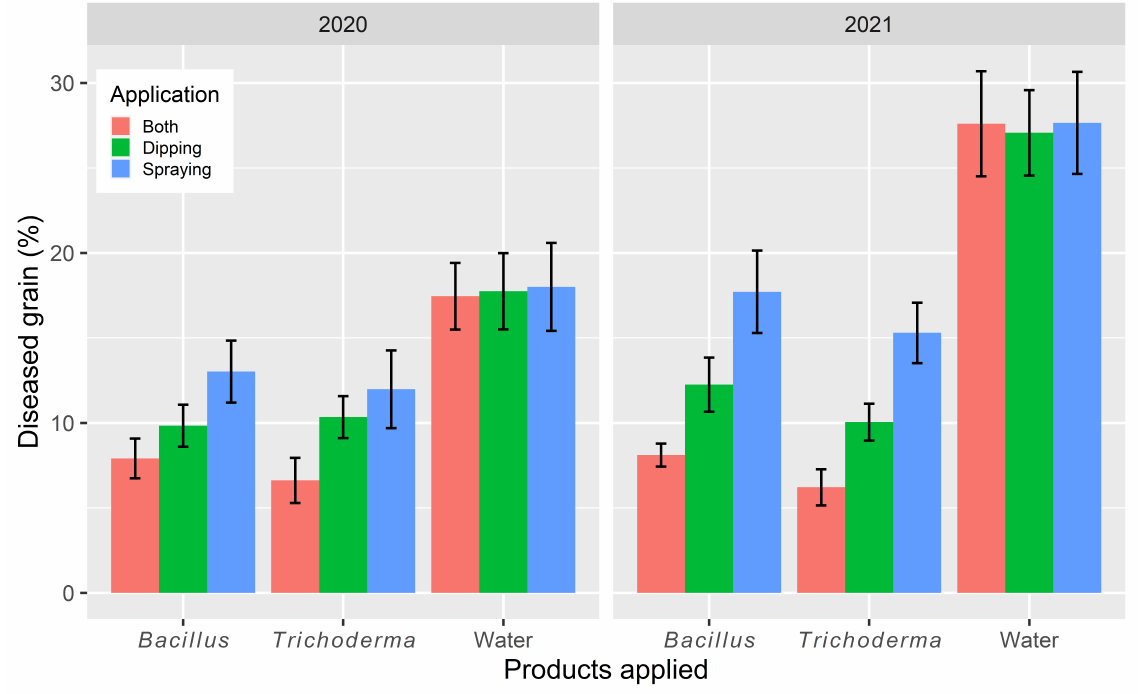
Figure 9. Percent grain with blast symptom in each plot of rice plants that received water or one of the two biopesticides at different times (dipping at transplanting, foliar spraying post-transplanting, or at both times) at three sites in 2020 and 2021 in Tanzania. The bar represents one standard